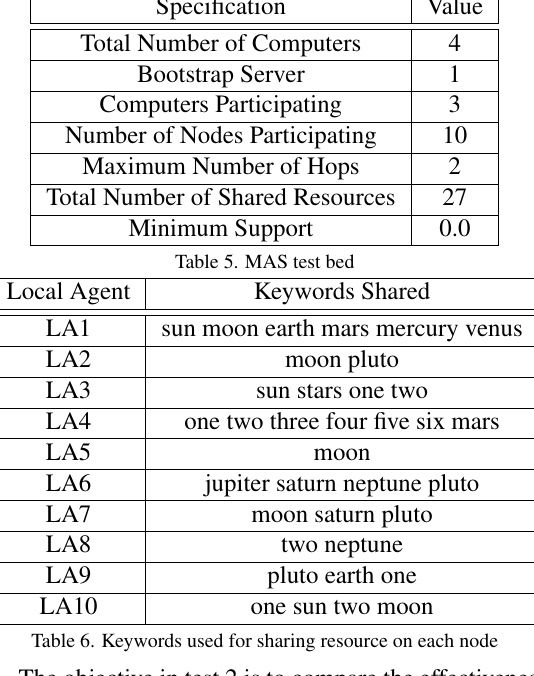
Table 5. MAS test bed